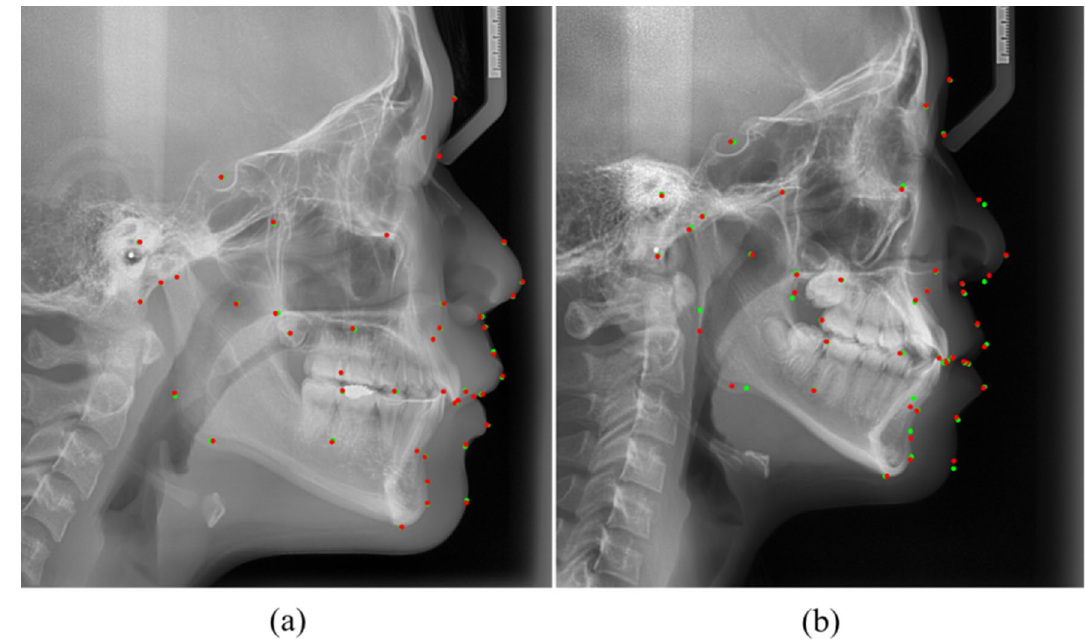
Figure 5. Experimental results of our proposed model. ( a ) shows the highest accuracy, and ( b ) shows the lowest accuracy in cephalometric X-ray images (red point, predicted landmark by deep learning; Green point, the ground